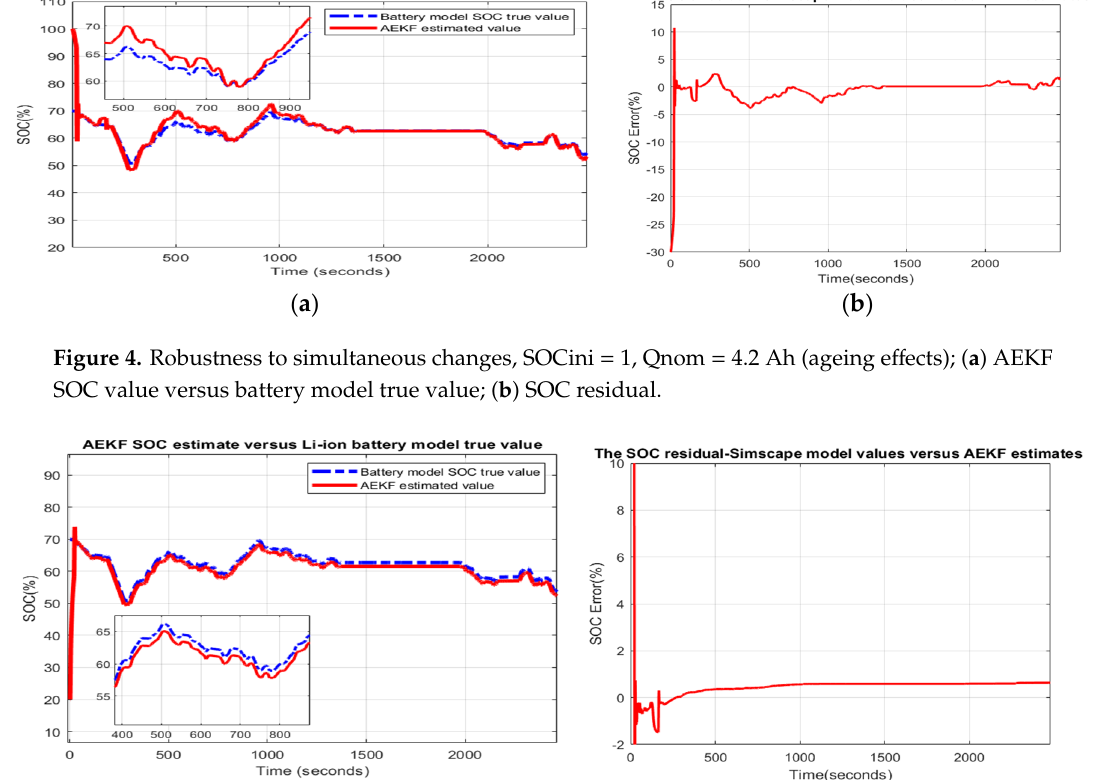
( a ) AEKF SOC value versus battery model true value; ( b ) SOC residual.